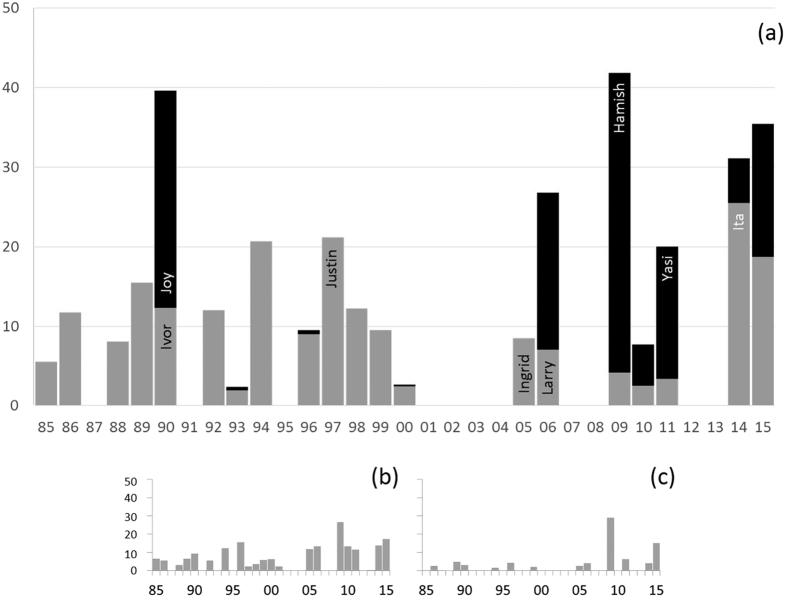
Percentage of the total GBR reef area within severe TC damage zones each year, 1985–2015, for models: (a) 4MW, (b) AHF and (c) FAB.For (a), when more than one TC occurred per year, the relative proportion of exposure attributable to each is shown by grey vs black shading. The 7 case study TCs are labelled. Model descriptions are in Table 1 and the Supplementary Material.